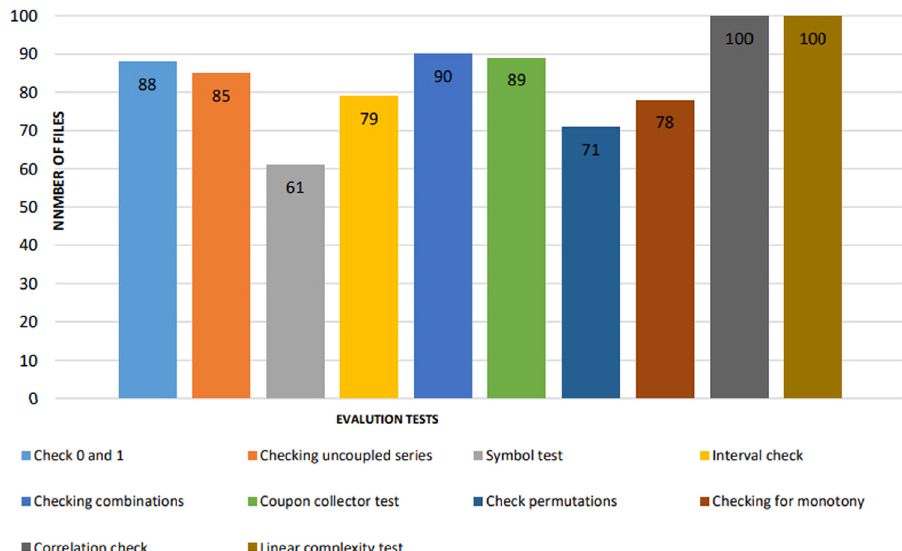
Figure 5: Evaluation test